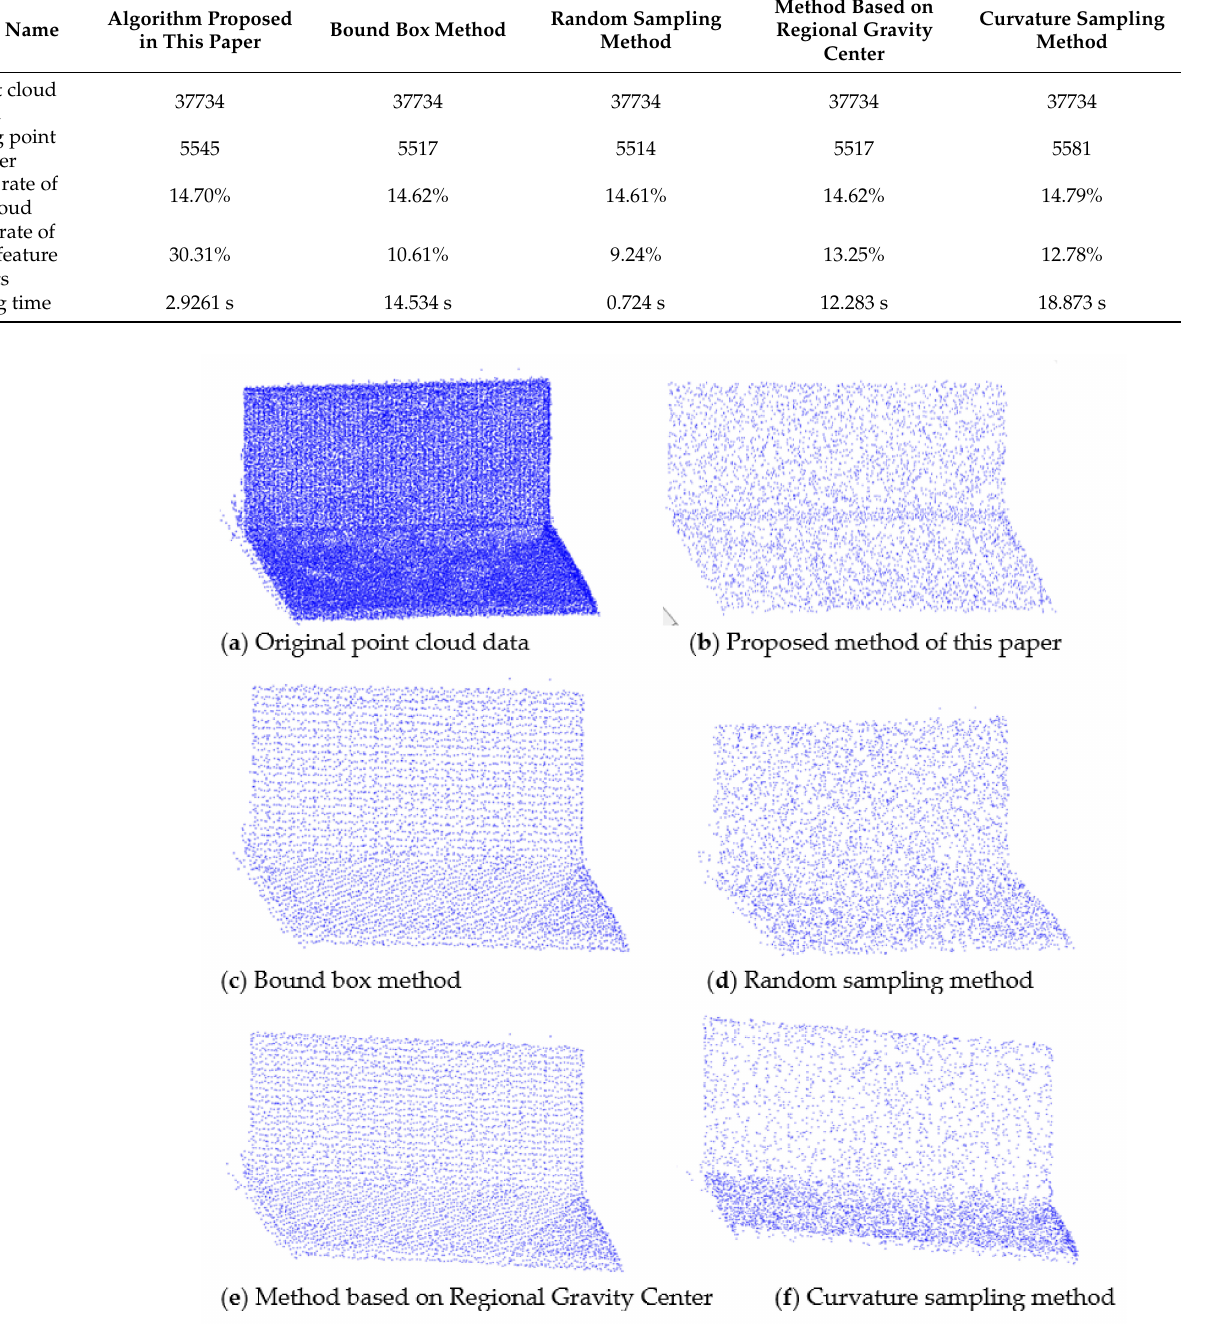
Figure 9. Five algorithms to simplify the T-profile steel